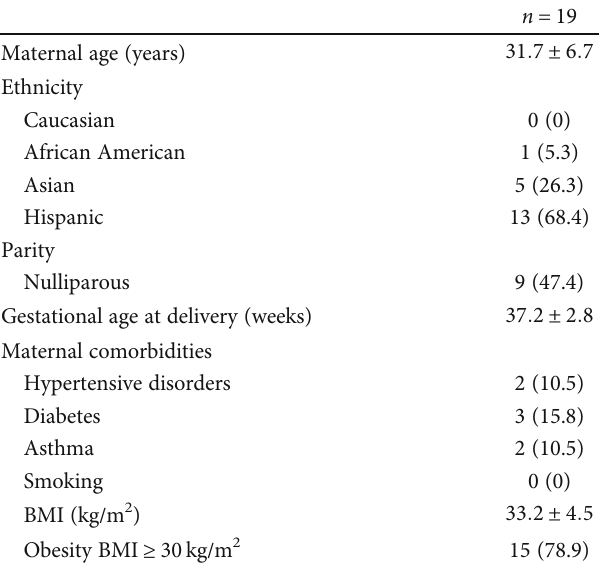
Figure 1: Flowchart of patients included in the analysis. Table 1: Maternal